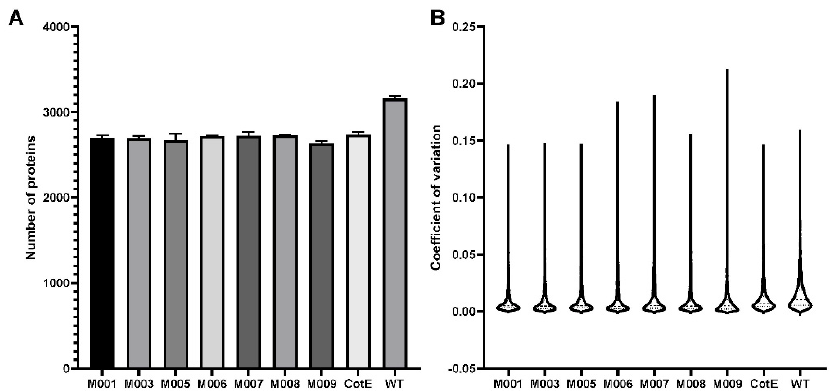
Figure 1. ( A ): The number of identified spore proteins in each strain. ( B ): Coefficient of variation between replicates of each strain.